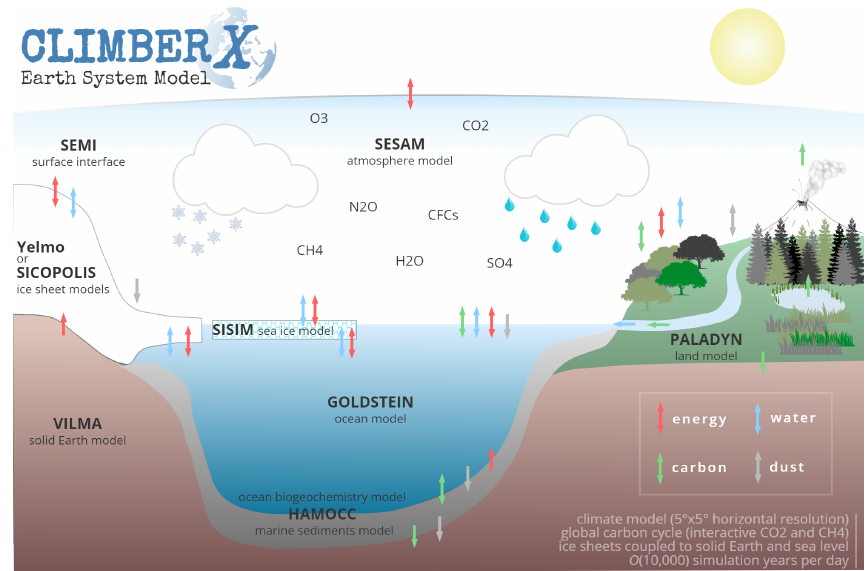
Figure 1. Schematic illustration of the CLIMBER-X model, including exchanges and coupling between the different modules.